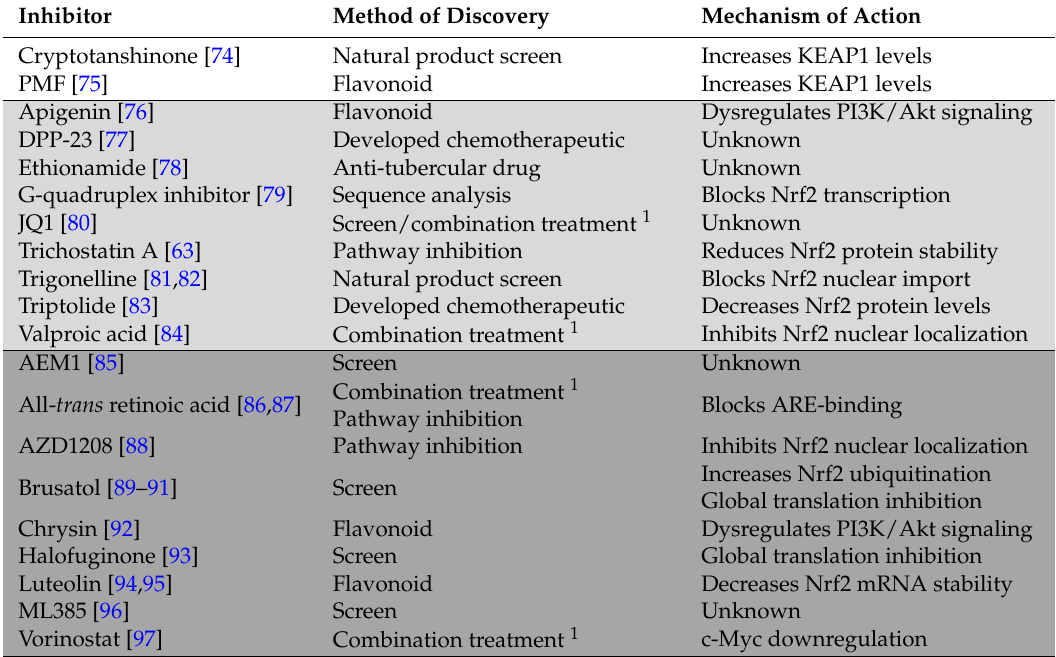
Table 2. Inhibition of Nrf2